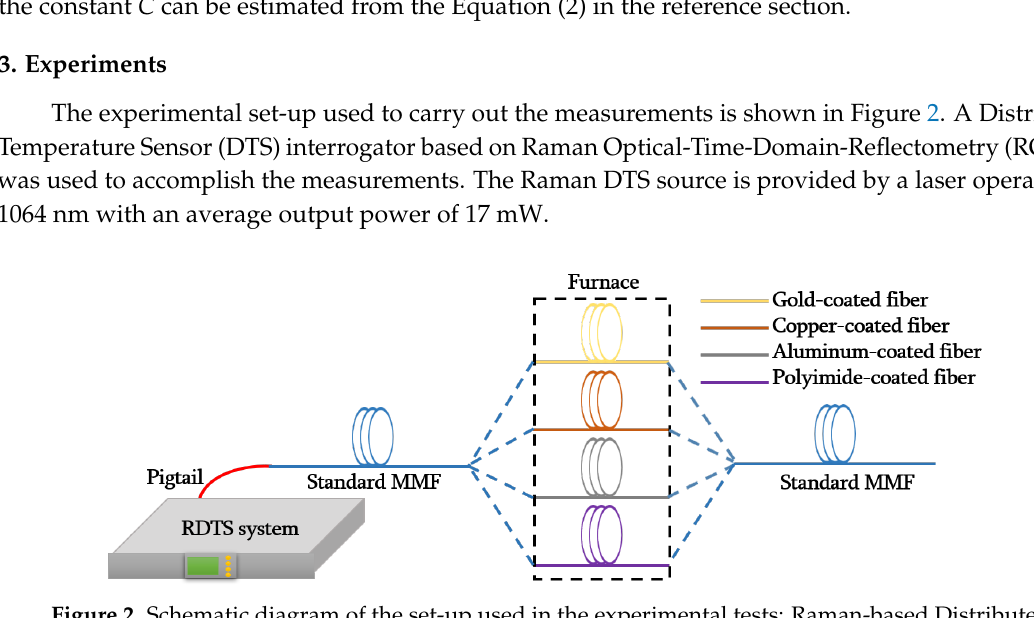
Figure 2. Schematic diagram of the set-up used in the experimental tests: Raman-based Distributed Temperature Sensor instrument (RDTS). Sensing fiber employed with standard multimode graded index fiber (blue) and special coated fibers: gold-coated fiber of 76 m length (yellow), copper-coated fiber of 40 m length (brown), aluminum-coated fiber of 64 m length (grey) and polyimide-coated fiber of 14 m length